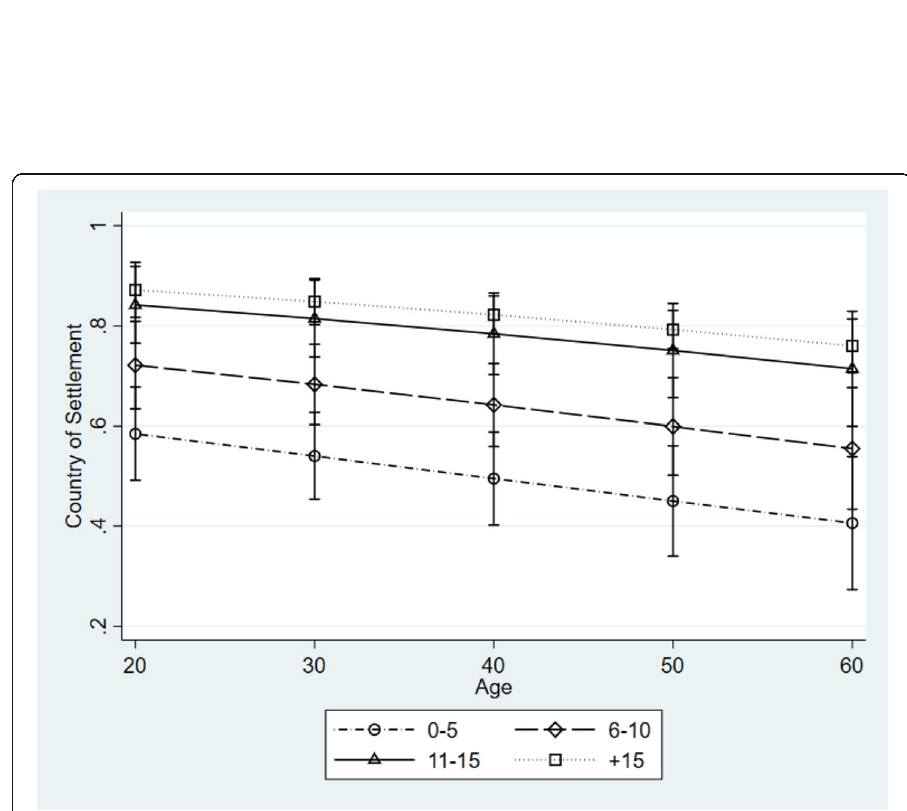
Fig. 5 Predictive margins of Emplacing home in country of settlement by age and length of